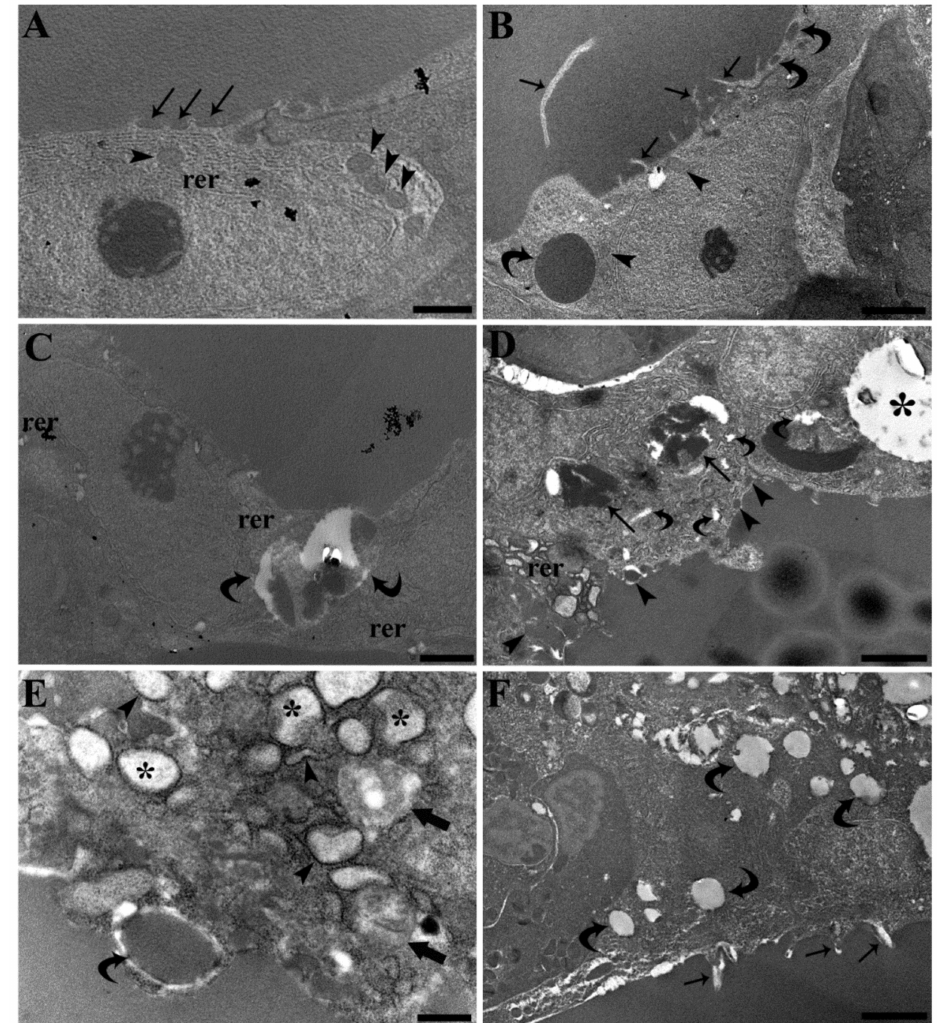
Figure 4. Transmission electron micrographs of ultrathin sections of common carp kidney. ( A ) A thyroid flattened pavement cell of an unexposed carp shows small colloid pinocytic caveolae (ar- rows), small mitochondria (arrowheads) and thin rough endoplasmic reticulum cisternae (rer). Scale bar = 1 µ m. ( B ) Thyroid cuboidal cells in an unexposed carp display elongated cellular projections (arrows) and vesicles suggestive of colloid endocytosis (curved arrows). Mitochondria are also visible (arrowheads). Scale bar = 2 µ m. ( C ) Phagolysosomes (curved arrows) and enlarged rough endoplasmic reticulum cisternae (rer) are appreciable in a cuboidal cell of an unexposed carp. Scale bar = 1 µ m. ( D ) Thyroid cuboidal cells of a carp exposed to 200 ng L − 1 PFOA display enhanced phagolysosomes formation (arrows), colloid endocytosis (arrowheads), enlargement and fragmenta- tion of rough endoplasmic reticulum cisternae (rer), cytoplasm vacuolation (asterisk) and rarefaction (curved arrows). Scale bar = 2 µ m. ( E ) The enlargement and fragmentation of rough endoplasmic reticulum cisternae are appreciable in a thyroid cuboidal cell of a carp exposed to 200 ng L − 1 PFOA. Flocculent material is appreciable inside the cisternae (asterisks) and the persistence of ribosomes is a remarkable feature (arrowheads). Endocytized colloid (curved arrow) is also visible along with areas of cytoplasm rarefaction (arrows). Scale bar = 0.5 µ m. ( F ) Thyroid cuboidal cells of a carp exposed to 2.0 mg L − 1 PFOA display impressive cytoplasm vacuolations (curved arrows) and cellular projections (arrows). Scale bar = 2 µ